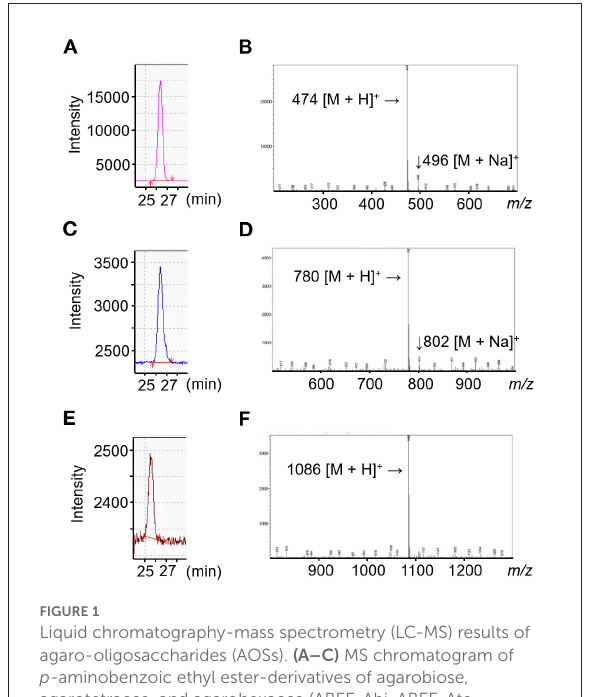
FIGURE1 Liquid chromatography-mass spectrometry (LC-MS) results of agaro-oligosaccharides (AOSs). (A–C) MS chromatogram of p -aminobenzoic ethyl ester-derivatives of agarobiose, agarotetraose, and agarohexaose (ABEE-Abi, ABEE-Ate, ABEE-Ahe). In the selected ion monitoring mode, ABEE-Abi (A) , ABEE-Ate (B) , and ABEE-Ahe (C) were detected at m/z 474, 780, and 1,086, respectively. (D–F) MS spectra of ABEE-AOSs.